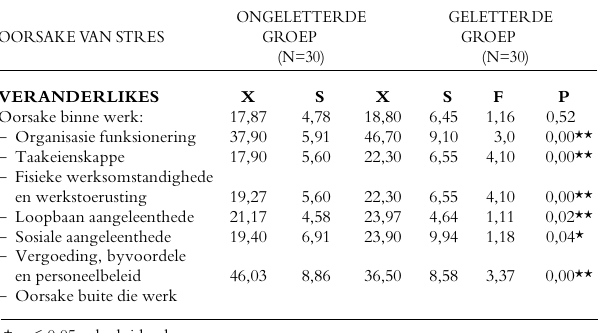
TABLE 3 OORSAKEVANSTRES: GROEPE